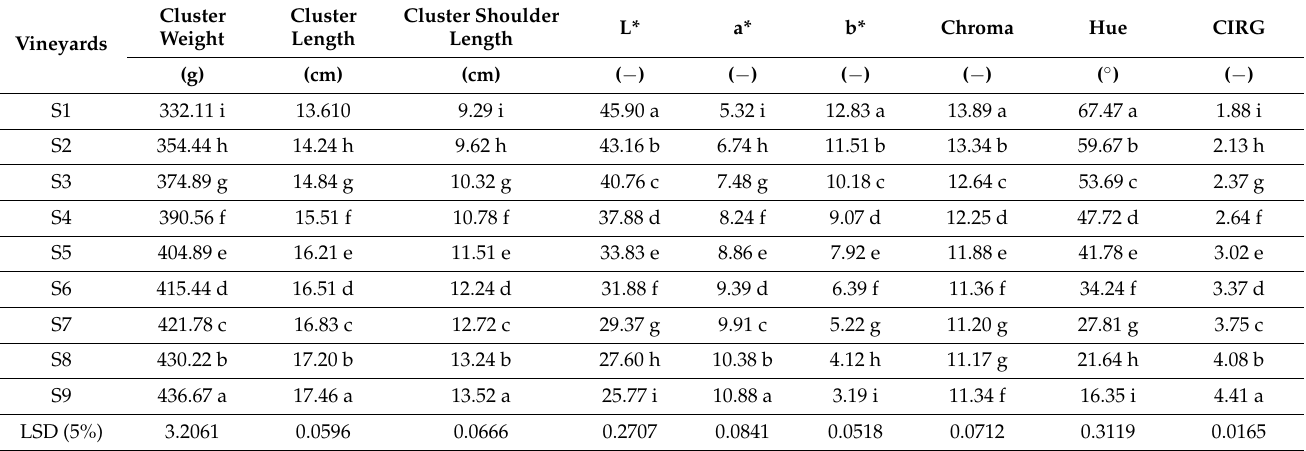
Table 5. Distribution of mean * values of cluster weight, cluster length, cluster shoulder length, color attributes of berries of Flame Seedless grape cultivated by different agricultural practices in investigated